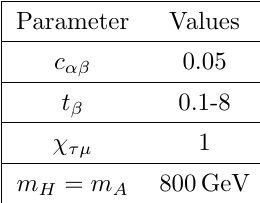
Table 1 . Values of the parameters used in the